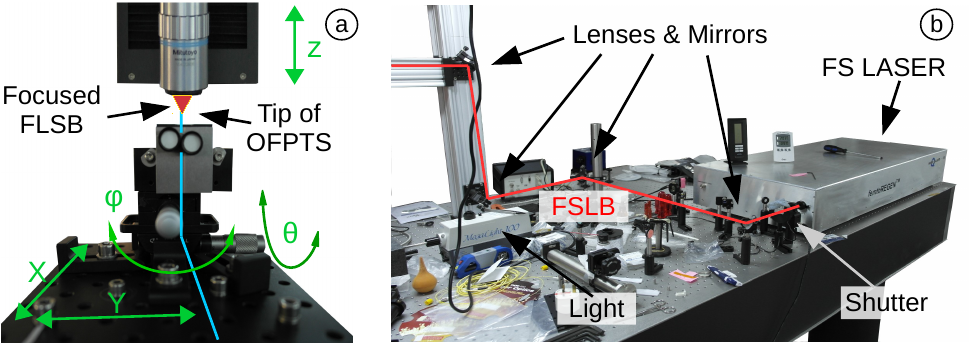
Figure 9. ( a ) OFPTS mounted vertically on the 3D-stage system; ( b ) FSL HighQ femtoREGENT 355 and equipment.